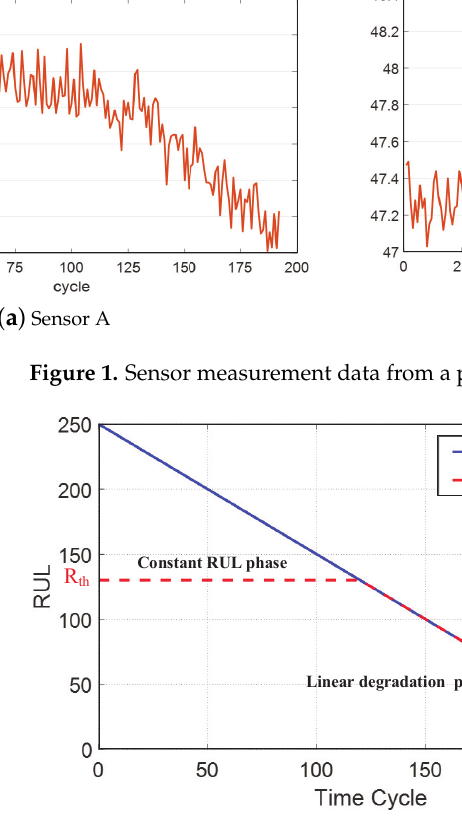
Figure 2. Piece-wise linear remaining useful life